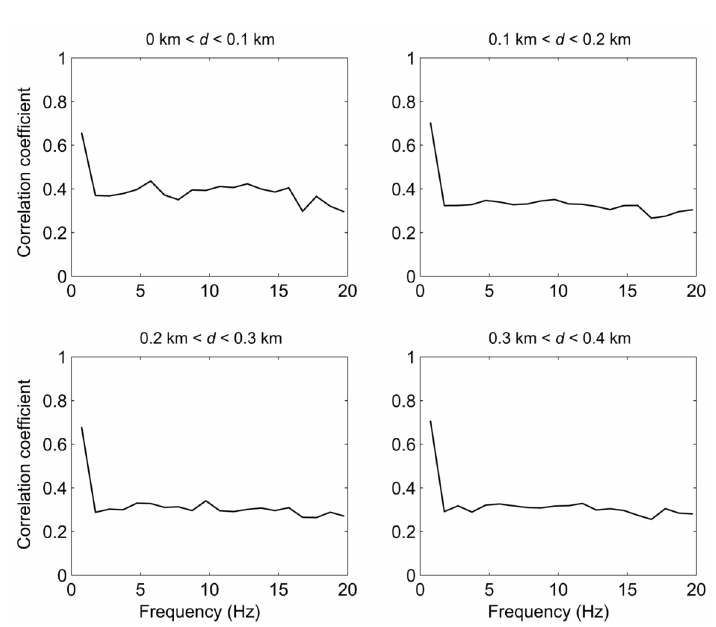
Fig. 4. Noise correlation as a function of frequency for different distance ranges. The correlation functions have been obtained from averaging the frequency-dependent correlation estimates associated with station pairs whose spacing d is included into the bounds reported at the top of each